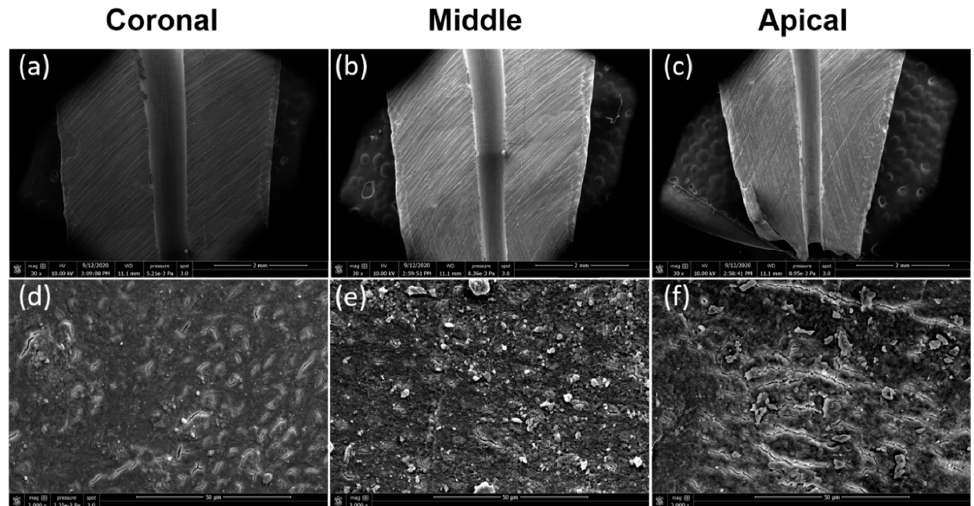
Figure 3. Representative scanning electron microscopy micrographs of longitudinal sectioned root surfaces after the shaping procedure. ( a ) Coronal third (×30 magnification); ( b ) middle third (×30 magnification); ( c ) apical third (×30 magnification); ( d ) coronal third (×2000 magnification); ( e ) middle third(×2000 magnification); ( f ) apical third (×2000 magnification).